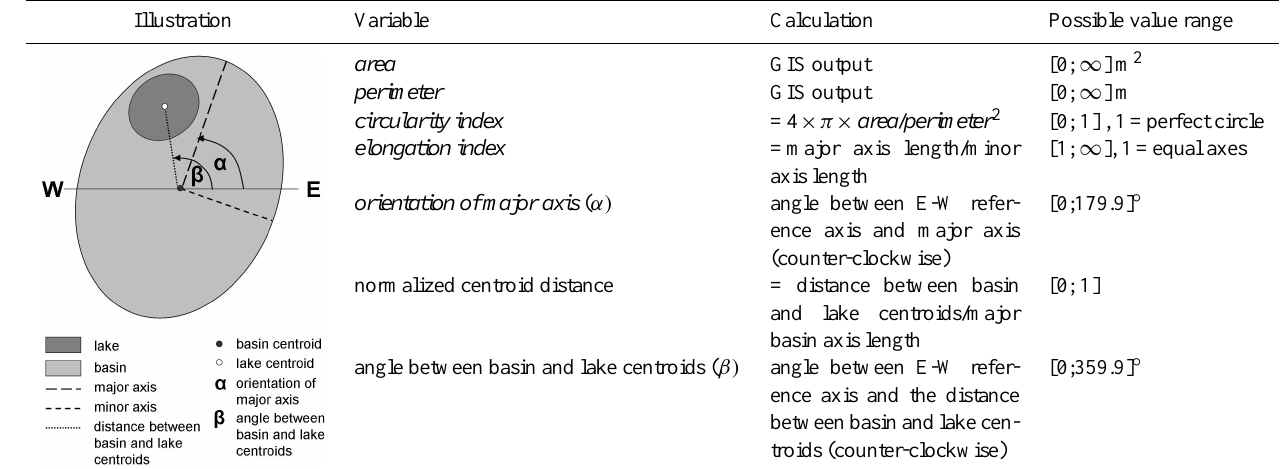
Table 1. Overview of morphometric variables calculated for lakes and basins. Major and minor axes lengths and orientation of major axis for lakes are not shown here, but were calculated the same way as for basins. 2 Illustration